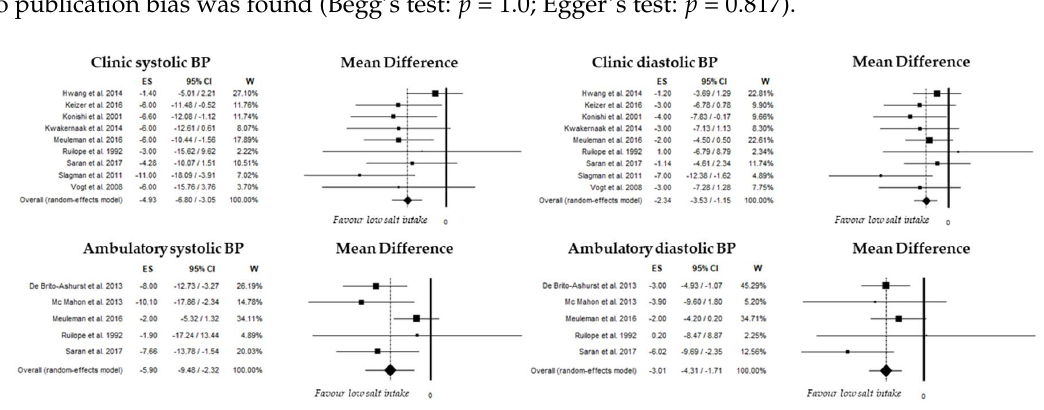
Figure 2. Mean difference of clinic and ambulatory blood pressure in low- and high-salt intake.